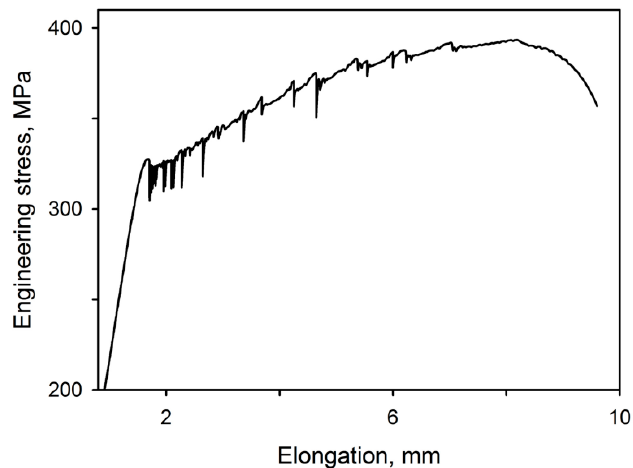
Figure 3. Example of a deformation curve for the ultra-fine-grained (UFG) alloy tested at r a = 3 × 10 − 5 s − 1 .